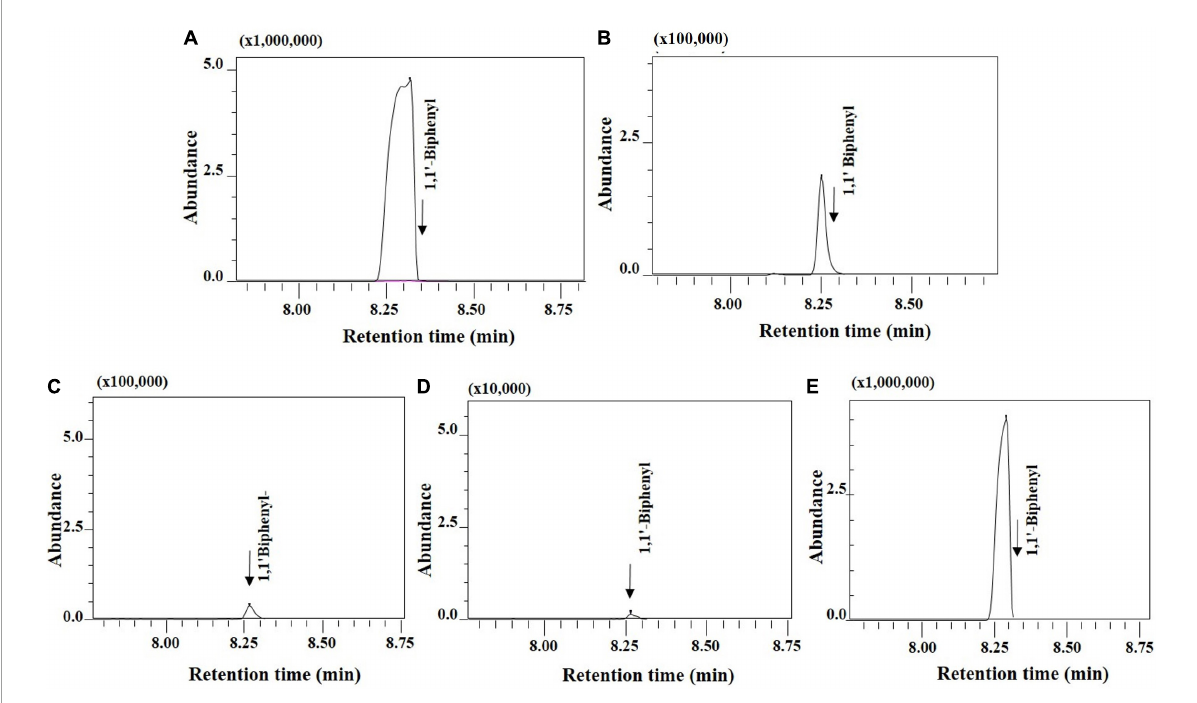
FIGURE5 Enhanced percentage of biphenyl degradation (200 mg/l) kept at 30 ◦ C for 48 h with optimized parameters (A) control without inoculum (B) P. aeruginosa MAPB-2 showing 67.5% (C) P. plecoglossicida MAPB-6 showing 97.1% (D) B. anthropi MAPB-9 showing 100% (E) P. megaterium MAPB-27 showing 53.3% degradation.